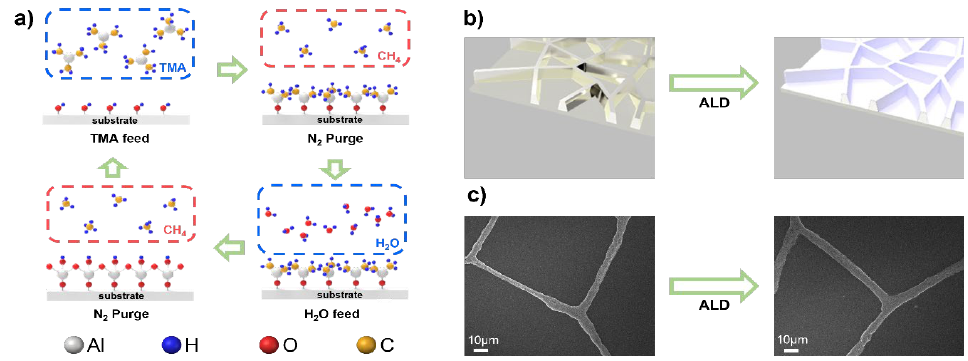
Figure 1. ( a ) Schematic of the ALD process for coating Al 2 O 3 on an Ag network. ( b ) Conceptual representation of the Ag network electrode states before and after Al 2 O 3 deposition. ( c ) Surface FE-SEM images of the Ag network electrode before and after Al 2 O 3 deposition.